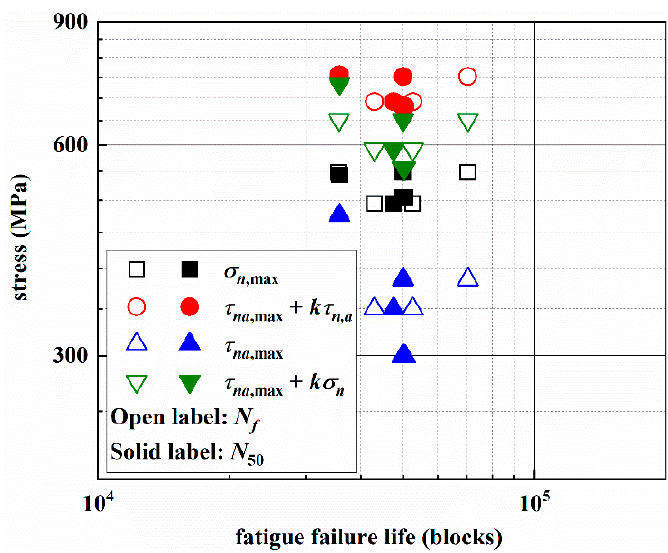
Figure 14. Relationship between stresses and the fatigue failure life.